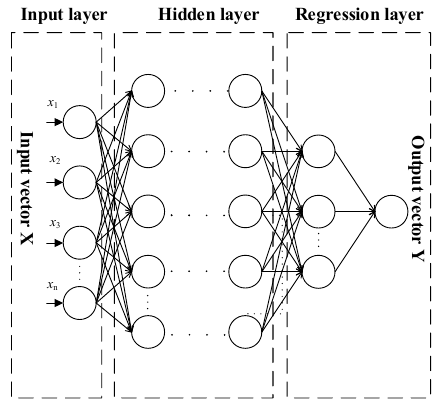
Figure 3 . Diagram of neural networks (NN) deployed at fog layers. Figure 3. Diagram of neural networks (NN) deployed at fog layers.